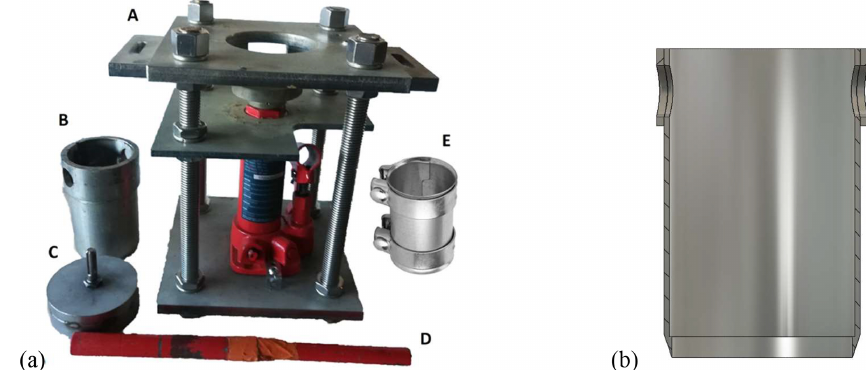
Figure 2. (a) Soil sample extruder: (A) car jack and stainless-steel frame, (B) soil sampler, (C) sampler cloche for pneumatic hammer, (D) car jack handle, (E) exhaust pipe clamp. (b) Sectional drawing of the